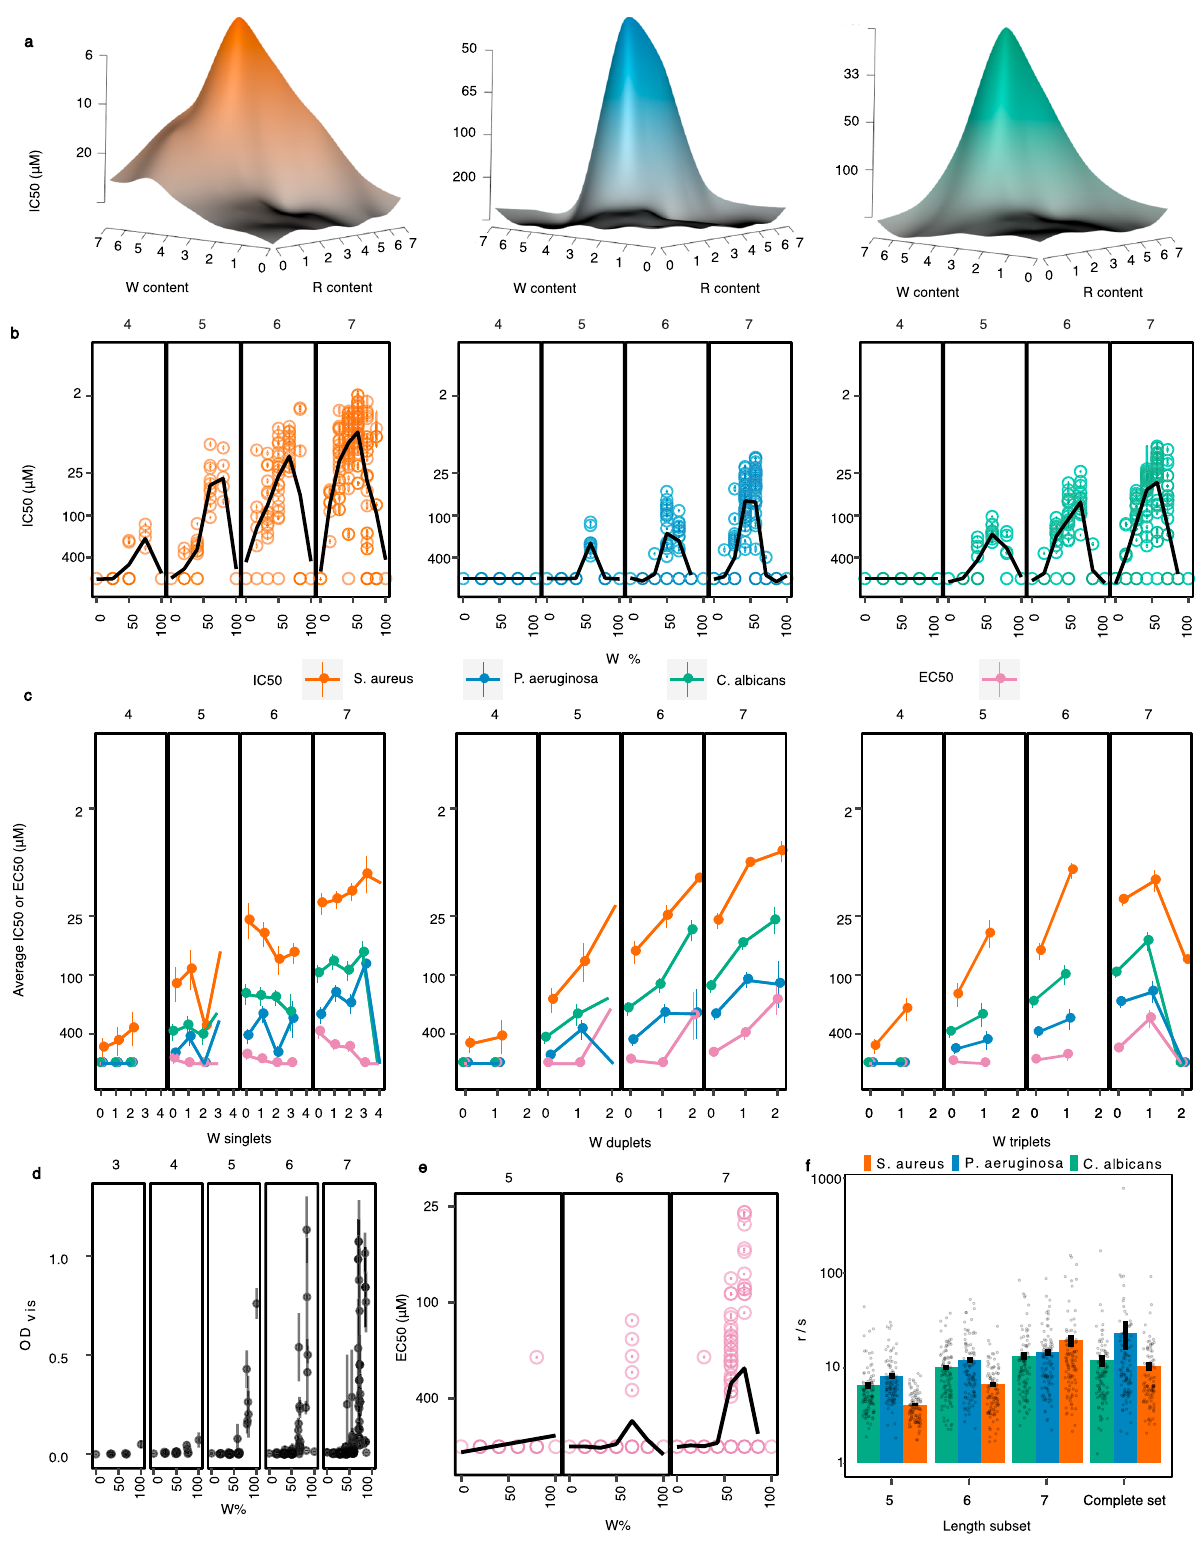
charged (anionic) or neutral lipid membranes. These composi- tions represent typical bacterial or mammalian cell membranes, respectively 22 The mass of bound heptapeptide was highest for neutral membranes for those heptapeptides with either four or fi ve W residues, and for the anionic model membranes for hep- tapeptides with 4 W residues (Fig. 4a). A signi fi cant